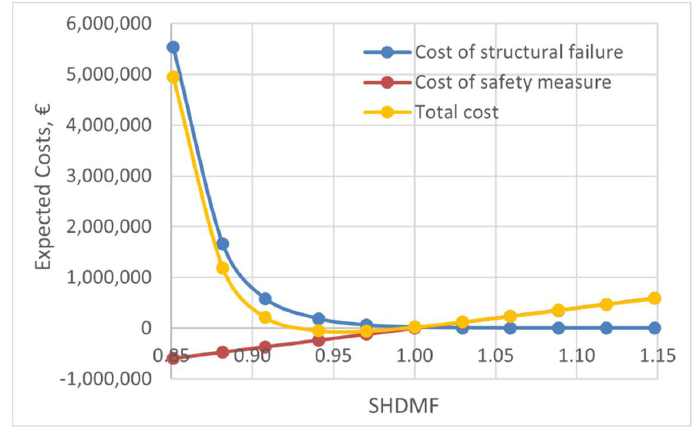
Figure 4. Cost of structural failure, safety measure, and total cost.